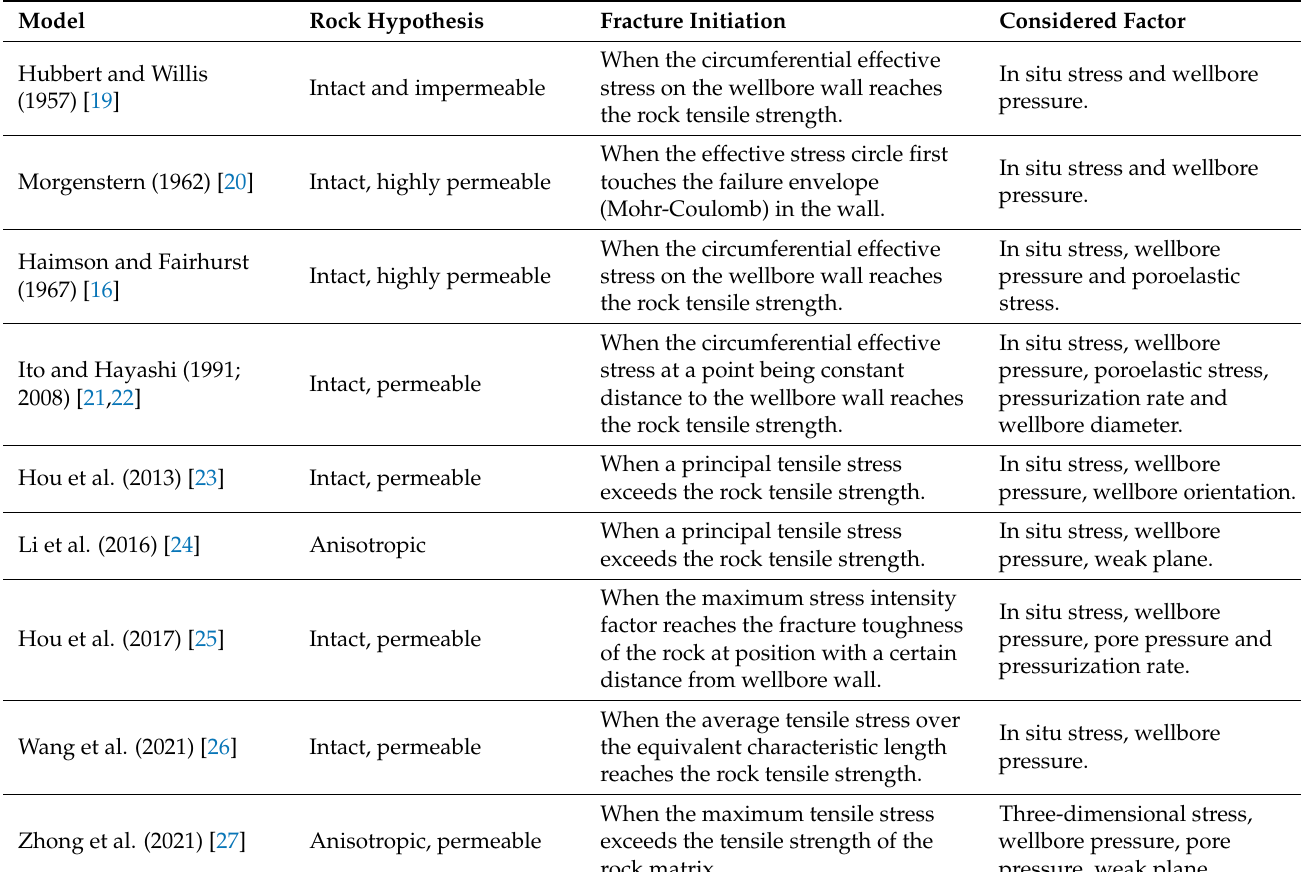
Table 1. Models for predicting the fracture initiation